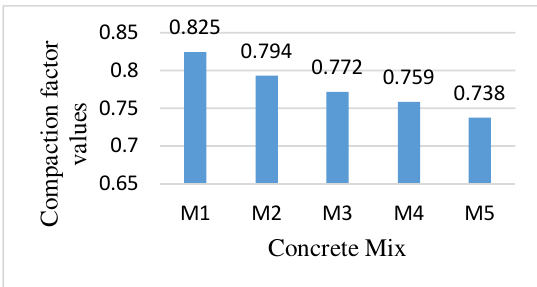
Fig. 3: Compaction aactor values for different concrete